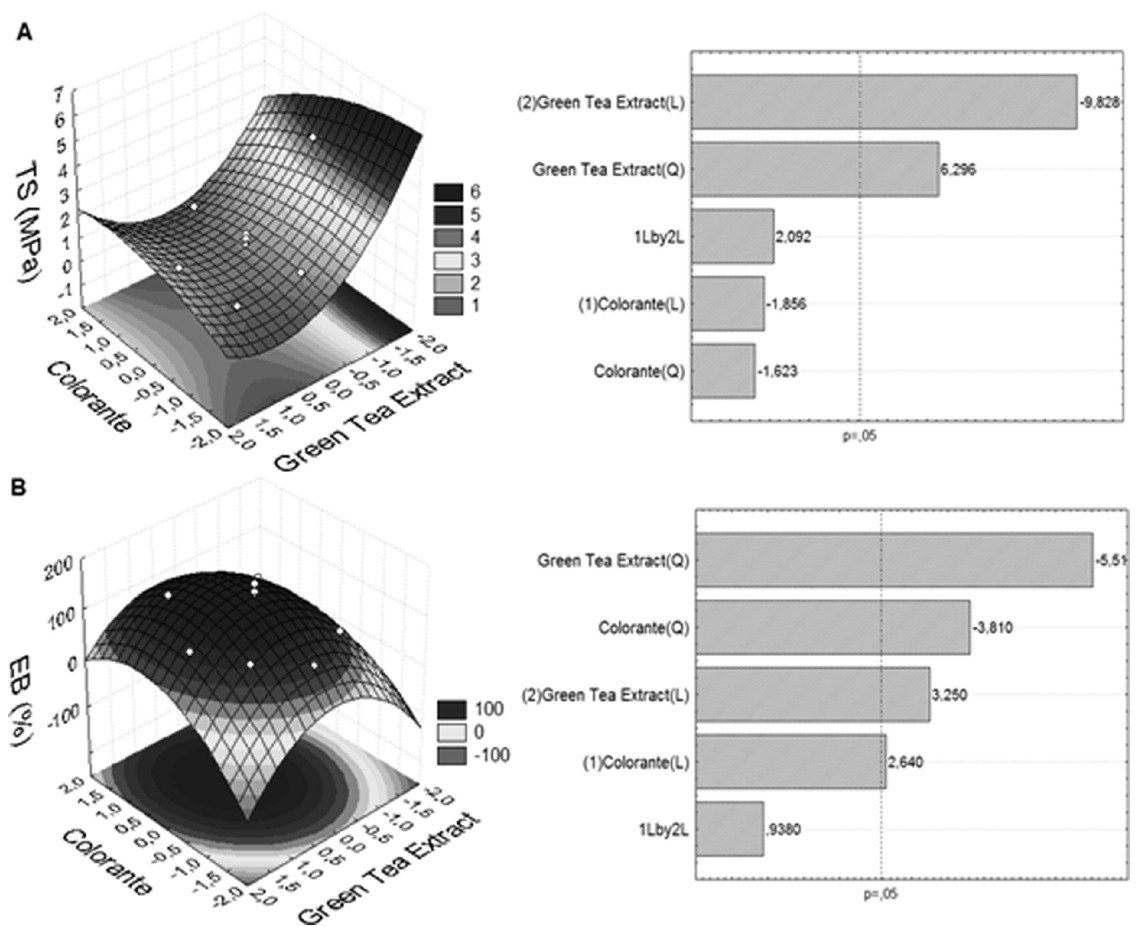
Figure 1. Response surface plot and Pareto chart for understanding the tensile strength (TS) and elongation at break percentage (EB) ( Y response), as function on the content of carotenoic colorant and green tea extract (coded values of X 1 e X 2 ).